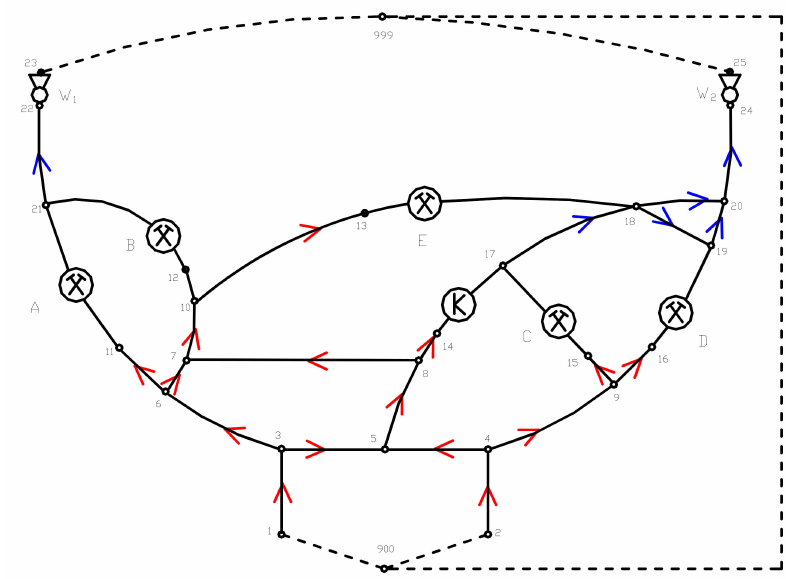
Figure 2. Canonical scheme of mine A (own work).